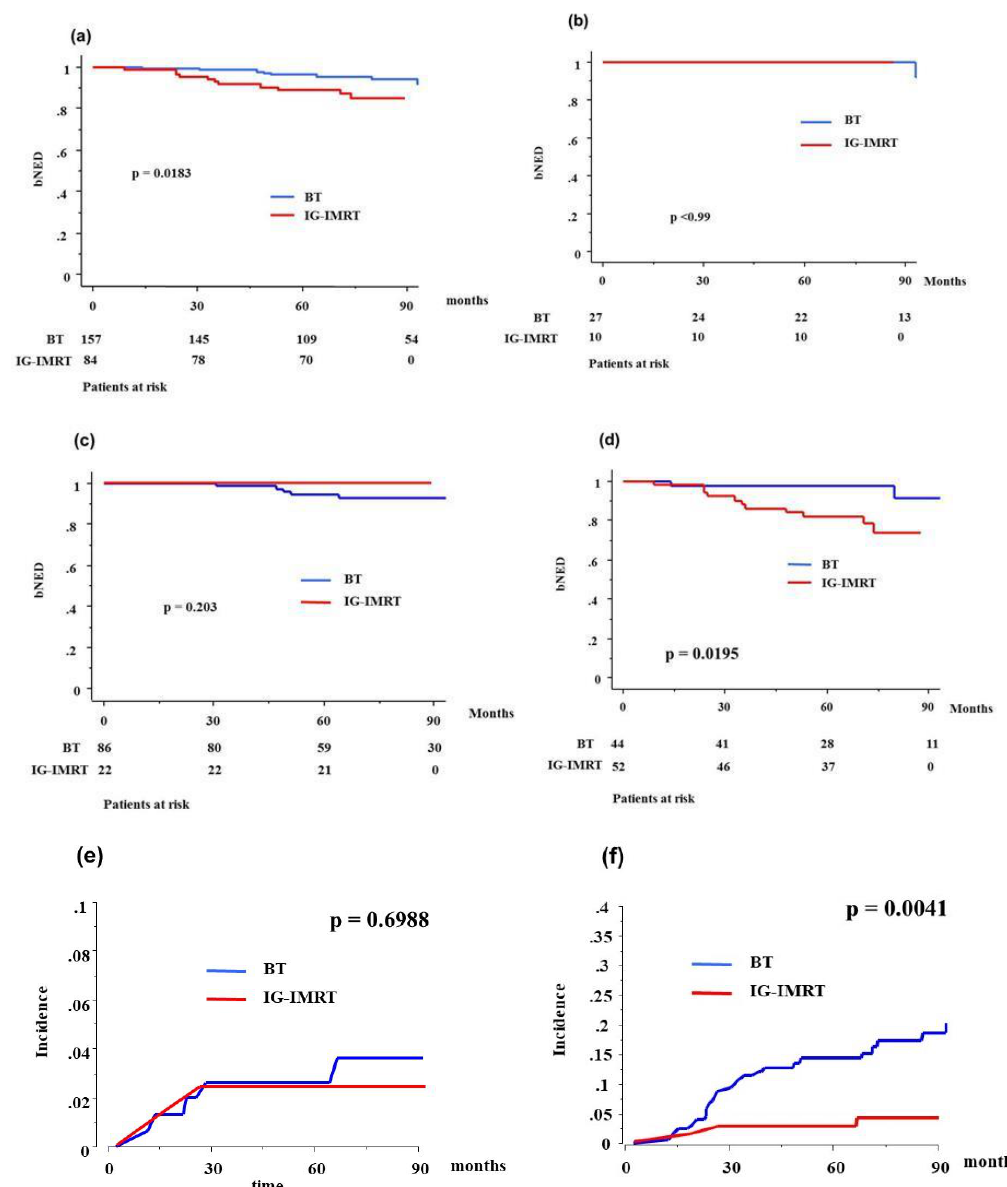
Figure 2. Biochemical control rates and accumulated incidence of grade ≥ 2 toxicity between brachytherapy (BT) and image-guided intensity-modulated radiotherapy (IG-IMRT) in elderly patients: ( a ) biochemical control rates between BT and IG-IMRT in elderly; ( b ) low-risk group; ( c ) intermediate-risk group; ( d ) high-risk group; ( e ) accumulated incidence of gastrointestinal toxicity grade ≥ 2 between BT and IG-IMRT; ( f ) accumulated incidence of genitourinary toxicity grade ≥ 2 between BT and IG-IMRT. bNED = no biochemical evidence of disease.